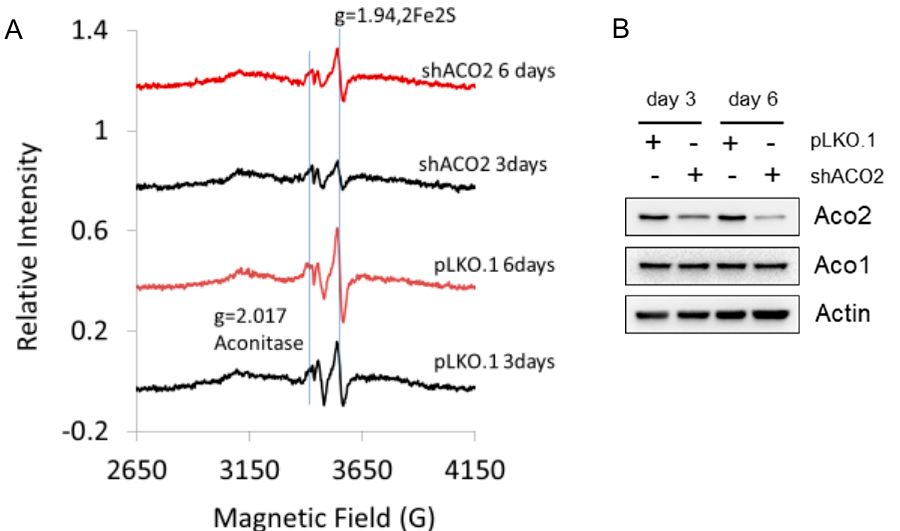
Figure 9. ( A ) A375 melanoma cells depleted of mitochondrial aconitase (shACO2) for three days (second from top spectrum, black) and six days (top spectrum, red). All cells were treated with 10 µ M chromate for 30 min before freezing. pLKO.1 is the control for shACO2. Spectrometer conditions: microwave freq., 9.632 GHz; mod. amp., 5 G; temp., 8.8 K, microwave power, 16 dB; ( B ) Western blot analysis of mitochondrial aconitase (ACO2) and cytosolic aconitase (ACO1) levels in A375 cells infected with lentiviral shACO2 or the control pLKO.1. Actin was the control for equal amounts of protein